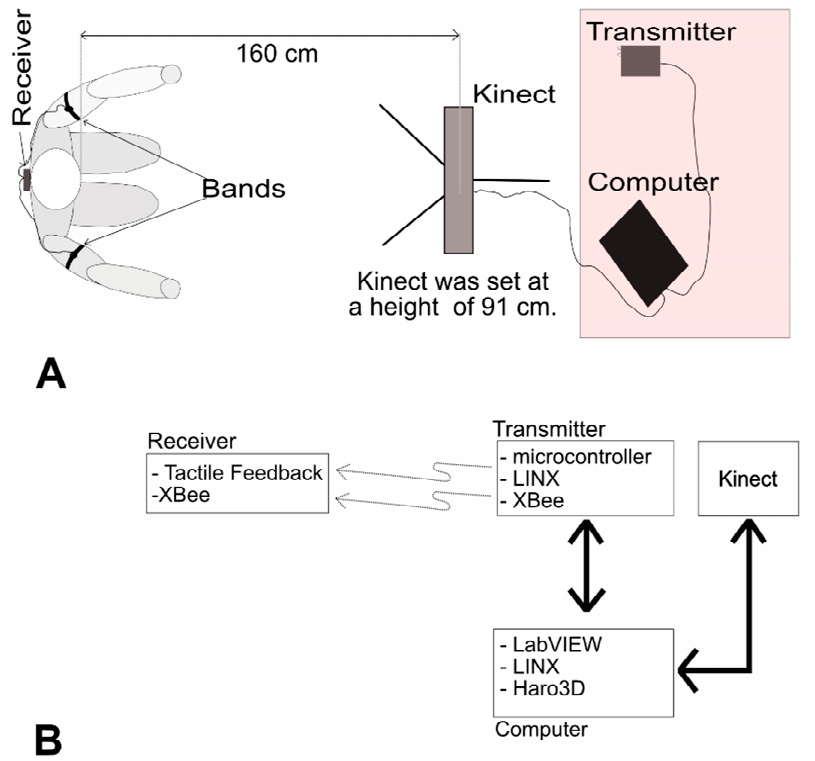
Figure 1. The training / rehabilitation system is shown: ( A ) It consists of a receiver with two bands that are put on the shoulders of the user for tactile feedback; a Kinect sensor placed 160 cm away from the user at a height of 91 cm; a transmitter that communicates with the receiver wirelessly, sending commands for tactile feedback, with two light emitting diodes (LEDs) serving as left- and right-arm visual feedback; and a computer connected to the Kinect and transmitter, which processes the joint information and executes a command according to the algorithm. ( B ) Hardware and software applied in the training system.